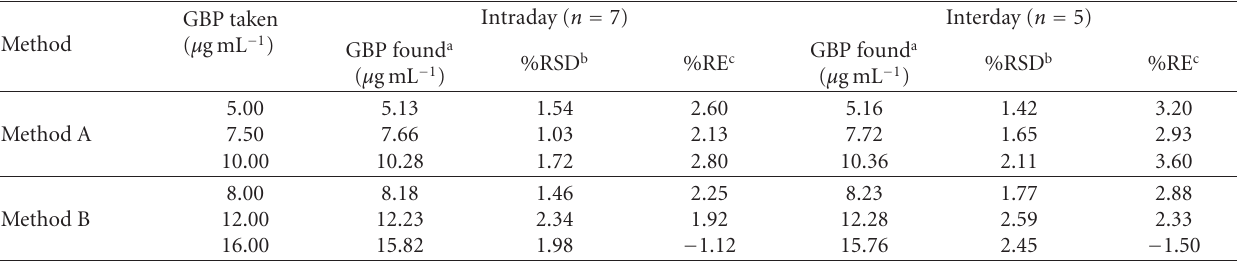
Table 4: Precision and accuracy.